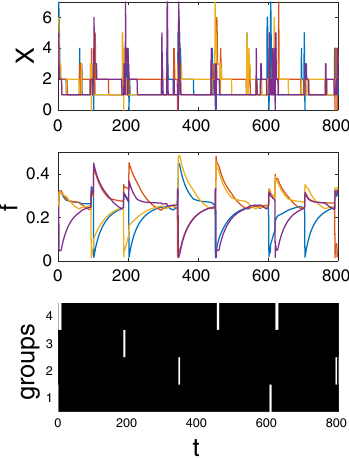
Figure 3. An example of non-equilibrium dynamics. Top: the number of contributing individuals in each group. Middle: faction powers. Bottom: groups cooperating at time t (i.e., those with θ j = 1 ) are shown as black pixels, while defecting groups (i.e., those with θ j = 0 ) are shown as white pixels. Four groups of size n = 10 each. Other parameters: b 1 = 10 , b 2 = 26 , ε = 0.1 , c = 1 , π 0 = 1 , X 0 = 5 , Z 0 = 50 , µ 1 = µ 2 = 0.25